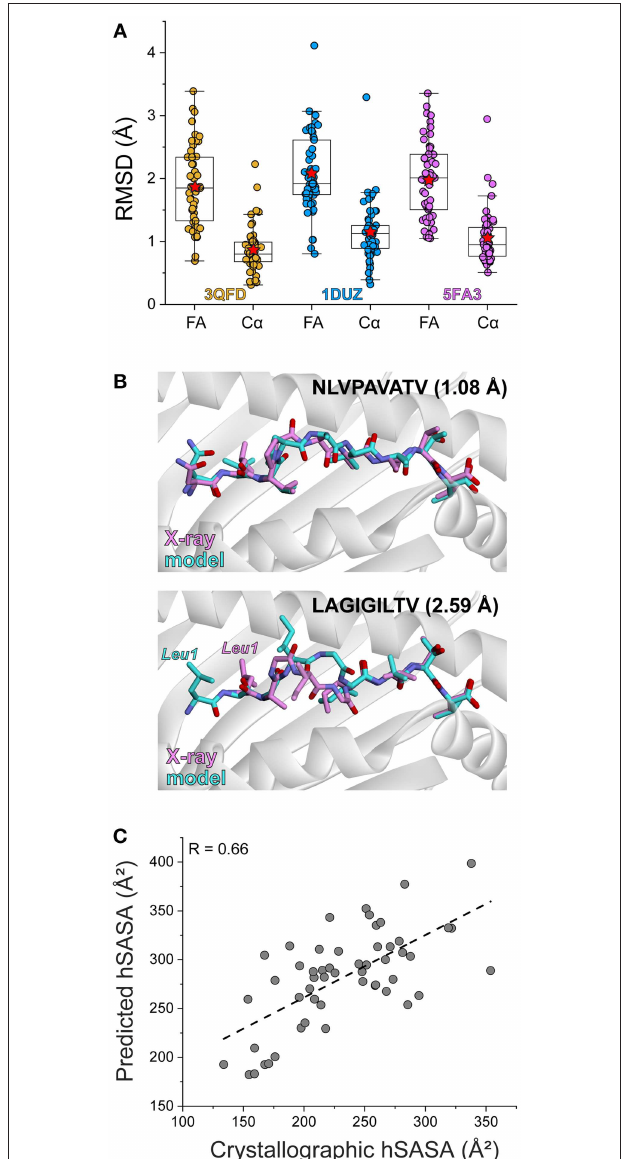
FIGURE 1 | Rapid structural modeling for peptide/HLA-A2 complexes. (A) Modeling performance as indicated by peptide C α and full atom (FA) RMSD values for modeled vs. crystallized peptide/HLA-A2 complexes. Boxes illustrate the 1st and 3rd quartiles, with a horizontal line at the median. Whiskers show 1.5 times the interquartile range. Red stars indicate mean values. Results for three templates (3QFD, 1DUZ, and 5FA3) are shown. The 3QFD template performed the best and was used for all further modeling efforts. (B) Structural images of representative models and their corresponding structures. The top shows the model of NLVPAVATV, which superimposes on the crystal structure with a full atom RMSD of 1.08 Å. The bottom shows the model of LAGIGILTV, which superimposes on the structure with a full atom RMSD of 2.59 Å. For the latter case, the leucine at position 1 forces the nonameric peptide to bind in a register-shifted decameric configuration, with the p1 leucine in the B rather than A pocket. Our modeling procedure did not permit such drastic conformational sampling. (C) Correlation between exposed peptide hydrophobic surface area in the models vs. the crystallographic structures. The two sets of data correlate with a R value of